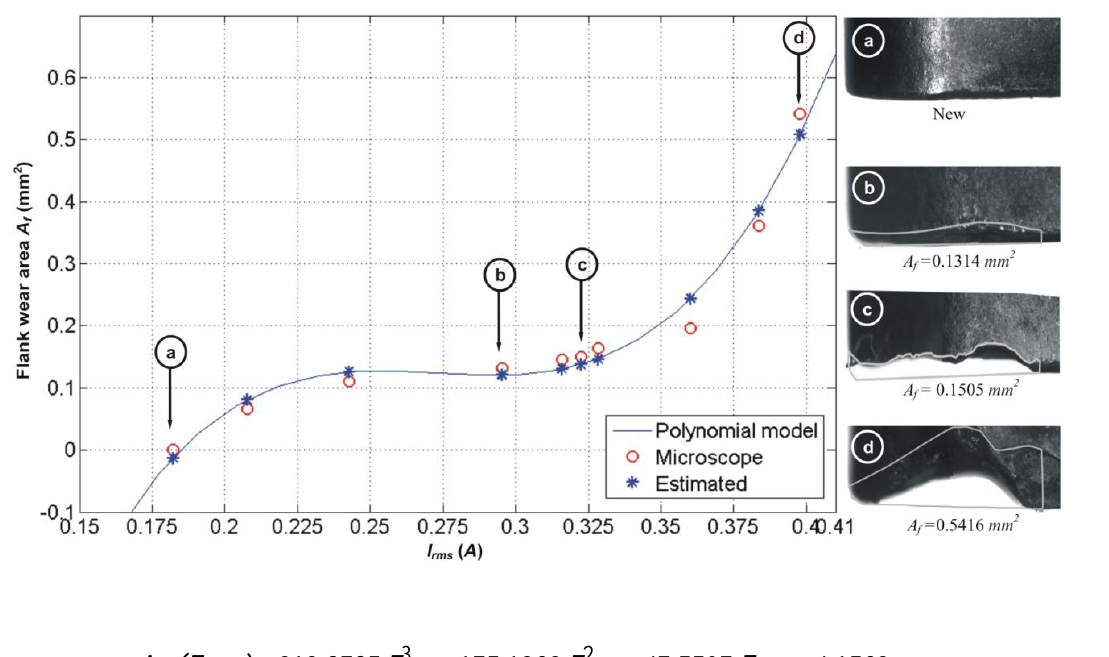
Figure 7. Flank-wear area estimation based on current signal, showing the micrograph of selected inserts and their corresponding tool-wear